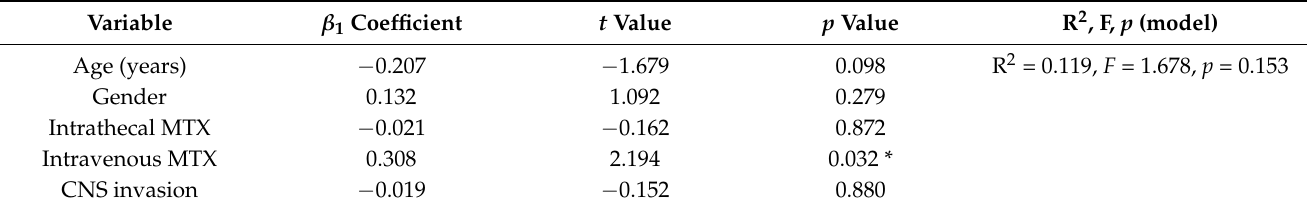
Table 3. Univariate linear regression analysis of effects of age, gender, treatment intensity, and CNS invasion on lesion size (logarithmically scaled).